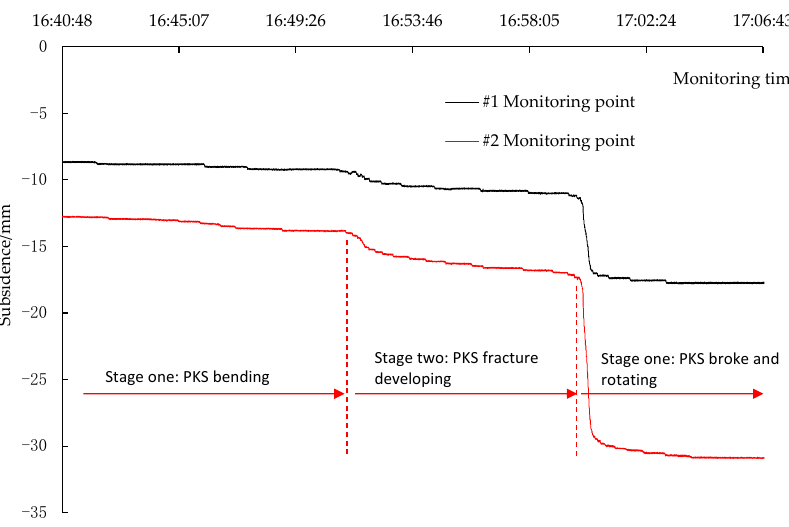
Table 3. Subsidence of the PKS in different stages.